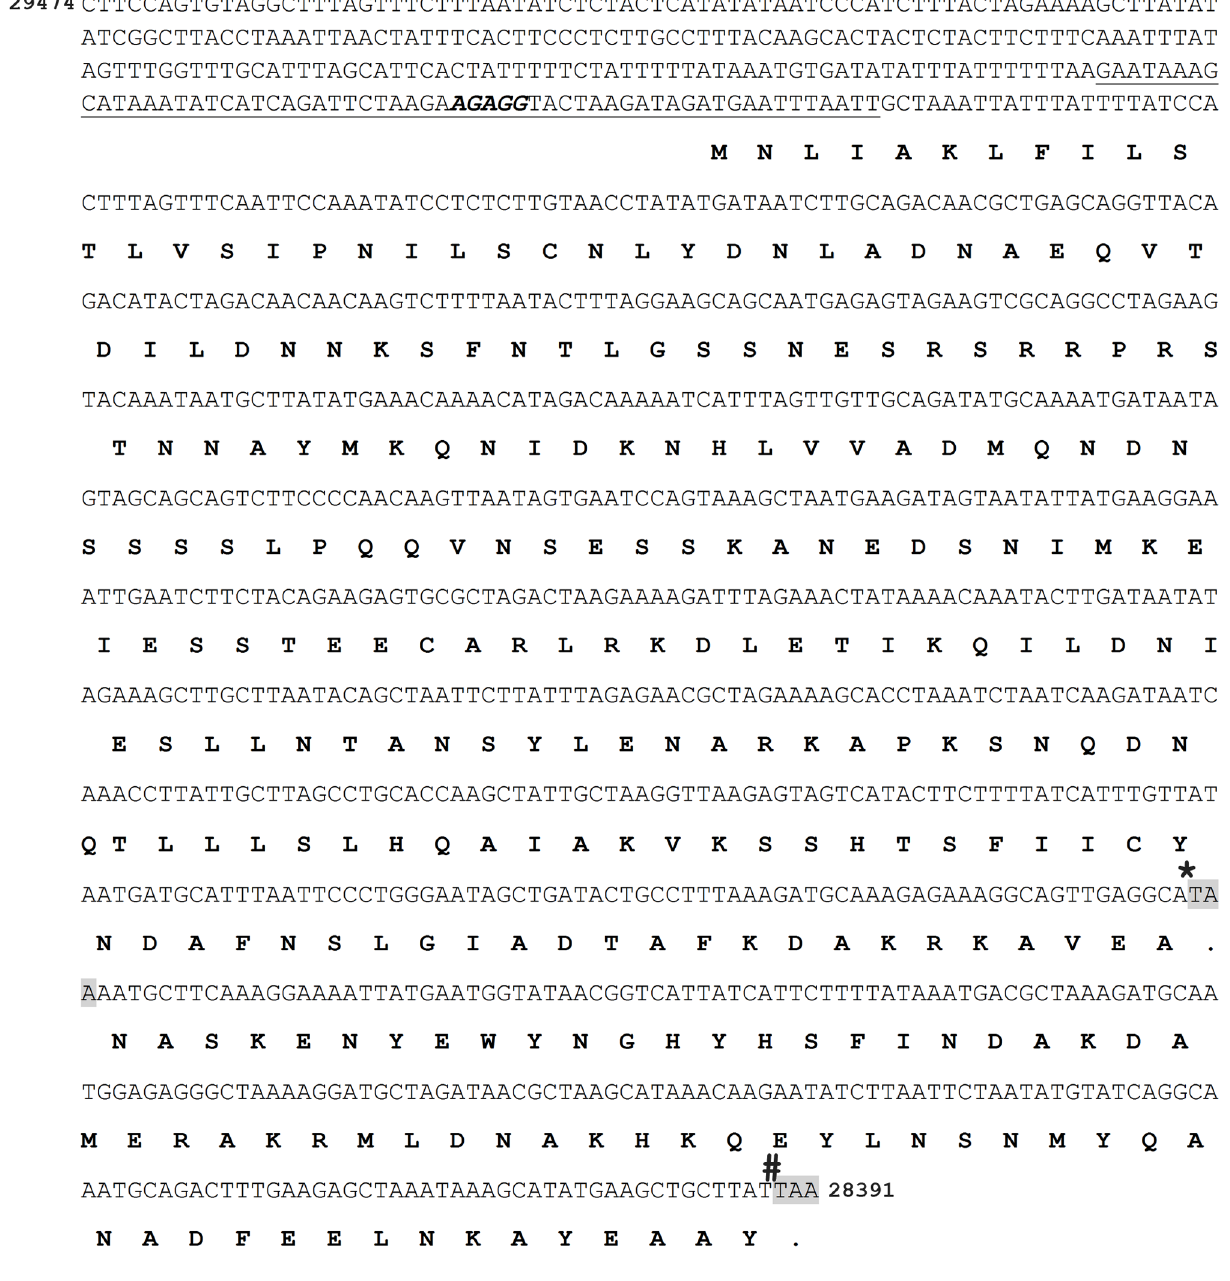
Figure 2. The nucleotide and putative amino acid sequence of the BBK46 open reading frame. The reverse complement of nucleotides 28391 to 29474 on lp36, encompassing bbk46 (Genbank GeneID: 1194234) and its putative promoter sequence. The nucleotide sequence of Bbive162 is underlined. The putative ribosome binding site is shown in bold italics. The putative BBK46 amino acid sequence is shown in bold. The stop codons at nucleotides 625 and 820 are highlighted in gray. The position of the inserted FLAG-epitope tag sequence is indicted with a star ( * ). The position of the inserted cMyc-epitope tag sequence is indicated with a number sign ( # ).